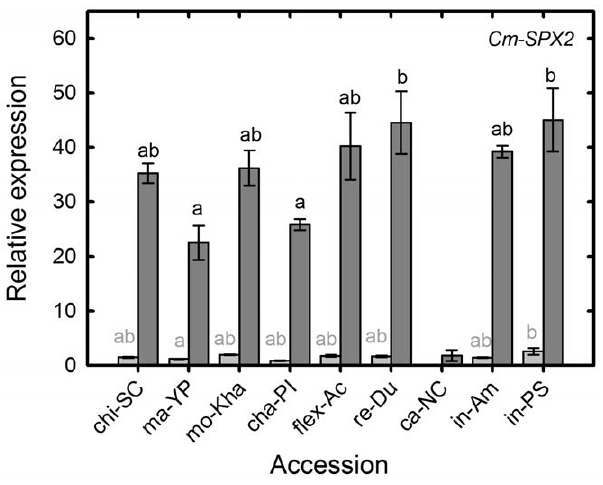
Figure 7. Relative root transcript abundance for CmSPX2 in nine different melon accessions under P replete and P starved conditions. Relative transcript abundance for CmSPX2 [MU43709/ MU63649] in different melon accessions grown hydroponically with a full nutrient solution (Control, light grey) or nutrient solution containing no phosphate (NoP, dark grey) for 21 d. Transcript abundance was measured using quantitative PCR (Q-PCR) and expressed relative to that of the housekeeping gene ( CmUbiquitin ). Grey bars with the same grey letter are not significant different at P , 0.05 by Newmans Keuls multiple range test. Dark grey bars with the same letter are not significant different at P , 0.05 by Newmans Keuls multiple range test.